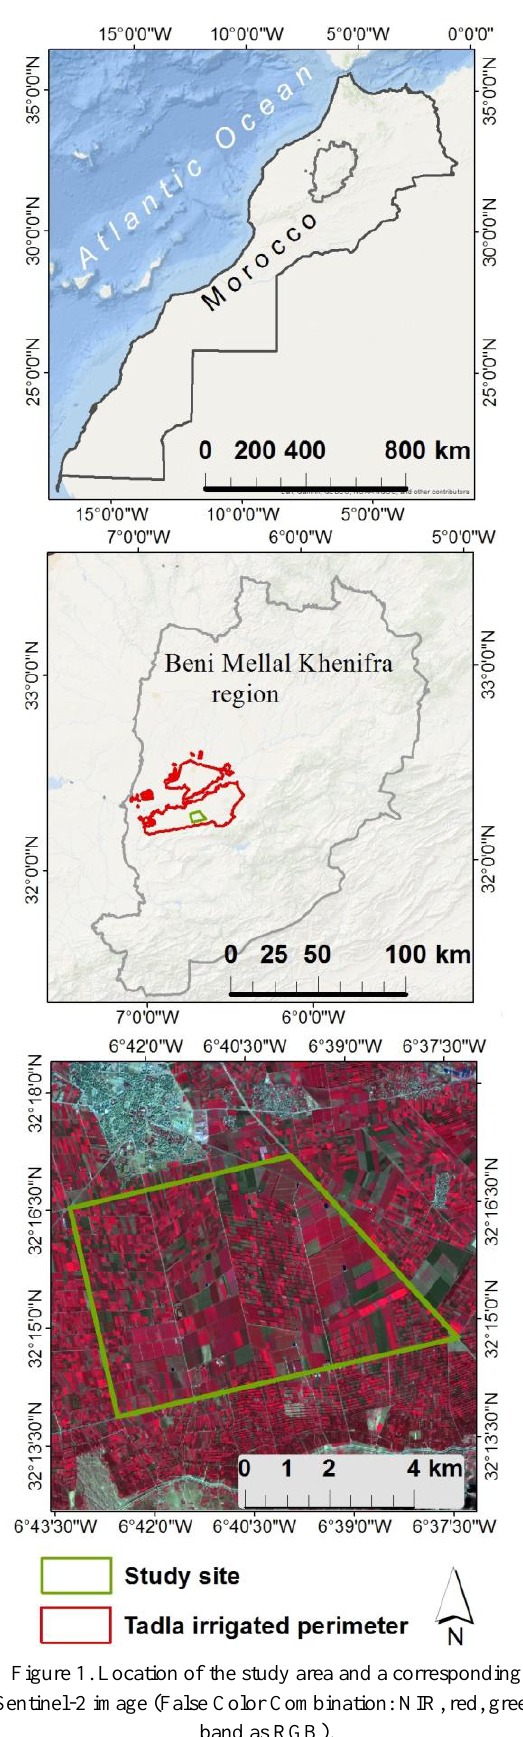
Figure 1. Location of the study area and a corresponding Sentinel-2 image (False Color Combination: NIR, red, green band as